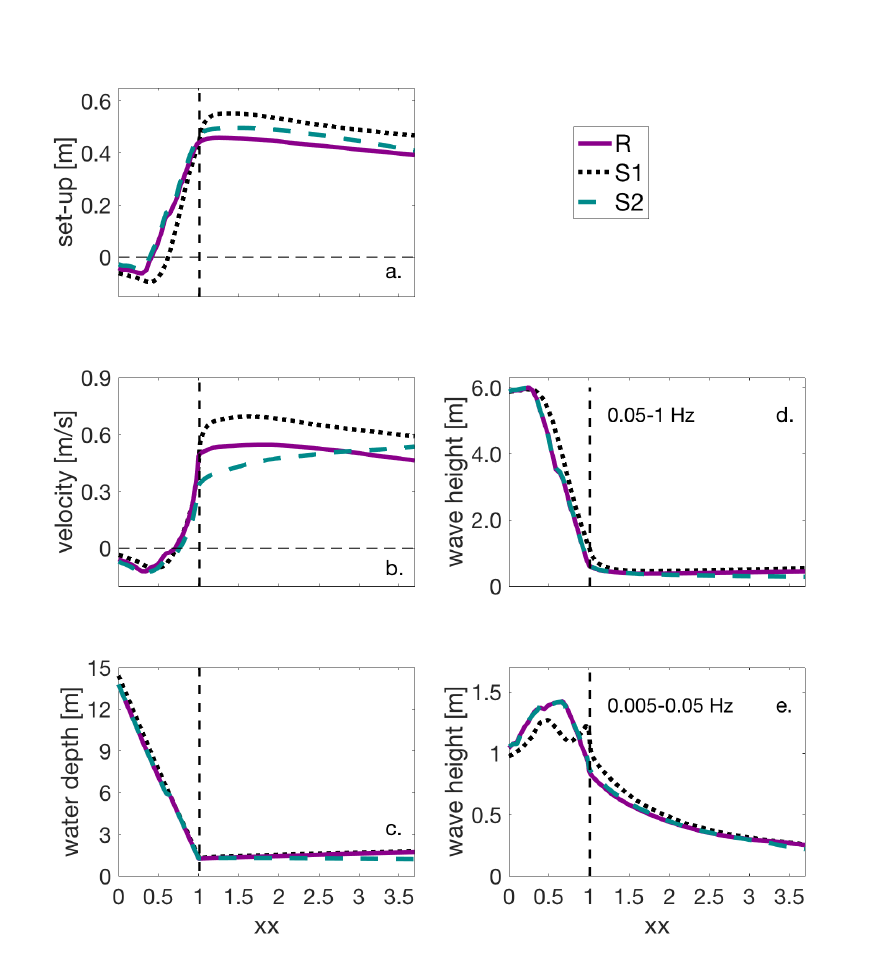
Figure 5. Modeled water level set-up ( a ) which includes elevated water levels in the basin, mean flow velocity ( b ), water depth ( c , including storm surge and wave set-up), short ( d ) and infragravity (IG) ( e ) wave heights and water depth for slopes R , S 1 and S 2 on a normalized grid ( xx ) from the beginning of the seaward slopes ( xx = 0) to the back barrier basin ( xx = 3.7). Grid locations before the crest (indicated by the vertical dashed line) indicate output in the same water depth (but not the same distance in reference to the crest), while they are equidistant and at the same depth after the crest for R and S 1 (but not for S 2 for which the island top has the same height as the